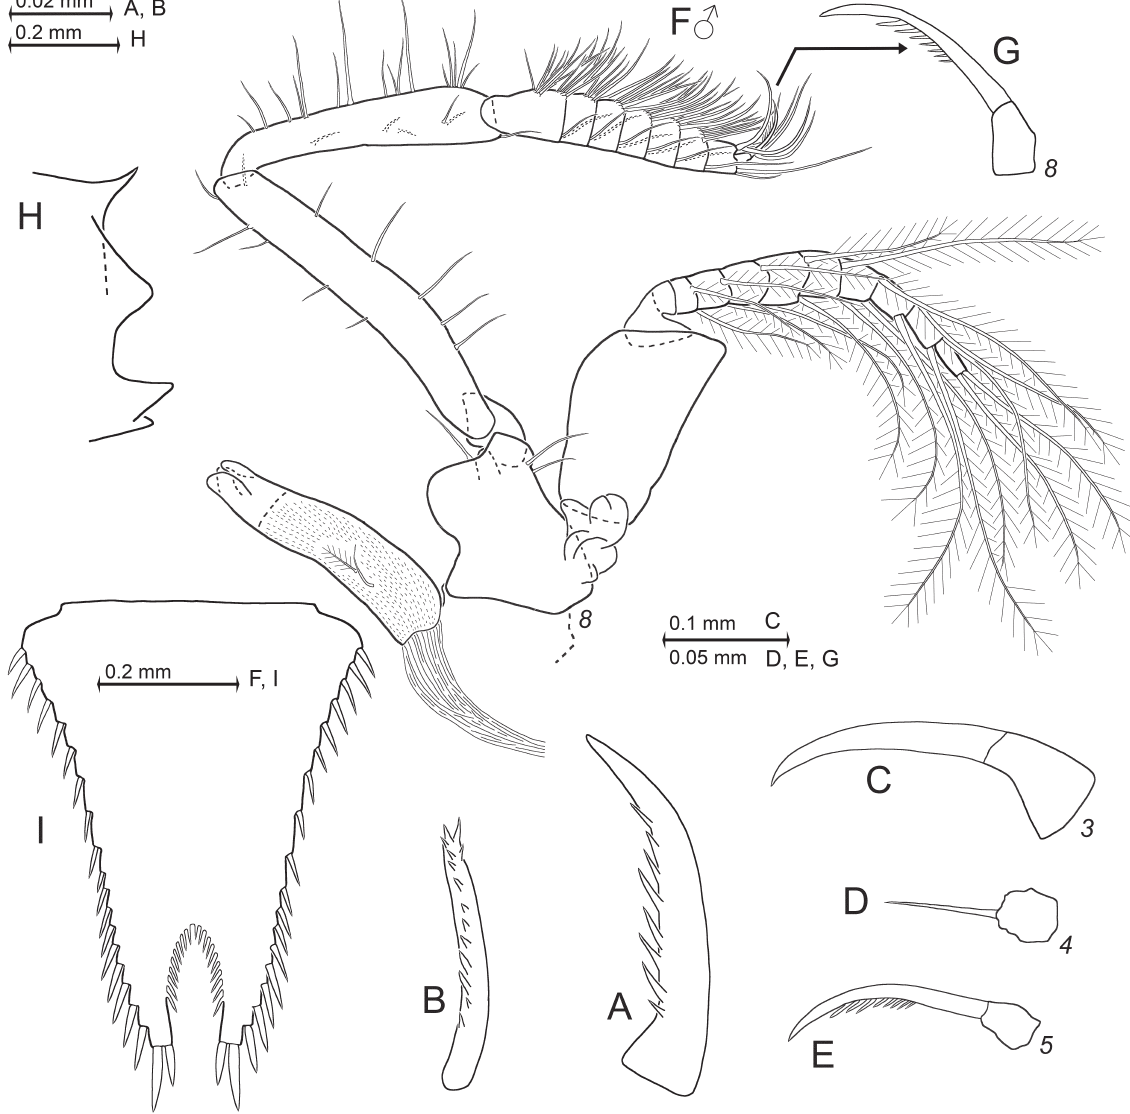
Fig. 6. Heteromysis hornimani sp. nov., paratypes, ♀ with body length 5.2 mm (A–C, H–I: NHMW 26975 ) and ♂ 4.7 mm (D–G: NHMW 26976). A–B . Modified spines from dorsolateral infoldings (A) and lateralia (B) of foregut. C–E . Series of dactylus 3–5, with claws, setae omitted. F . Thoracopod 8 with penis, rostral. G . Detail of endopod 8 (F) showing dactylus with nail. H . Scutellum paracaudale, lateral. I .